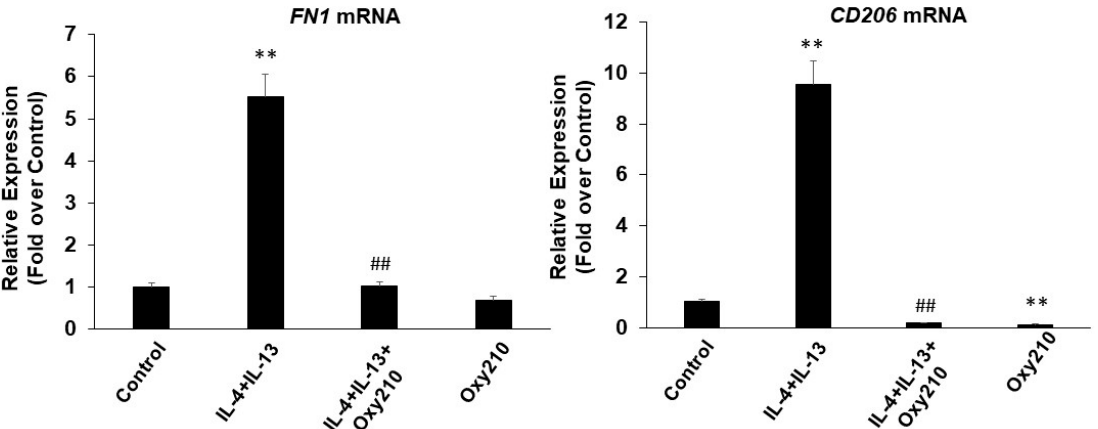
Figure 16. Inhibition of IL-4+IL-13 induced M2 polarization of THP-1 macrophages by Oxy210. Cells were pretreated with Oxy210 (2.5 μ M) in RPMI containing 0.1% FBS for 24 h followed by the addition of IL-4+IL-13 (20 ng/mL each) in the absence or presence of Oxy210 (2.5 μ M). After 48 h, RNA was extracted and analyzed by Q-RT-PCR for the expression of the genes as indicated and normalized to GAPDH. Data from a representative experiment are reported as the mean of triplicate determinations ± SD (** p < 0.01 vs. control; ## p < 0.01 vs. IL-4+IL-13).